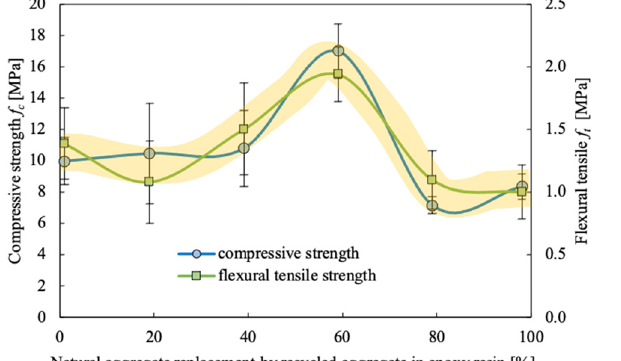
Figure 9: Scheme of the distance between the location of use and the suppliers of the materials.